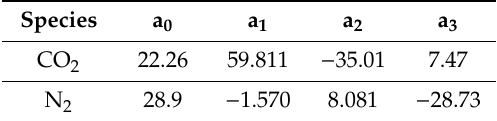
Table 2. Molar heat capacity vs. temperature of CO 2 and N 2.